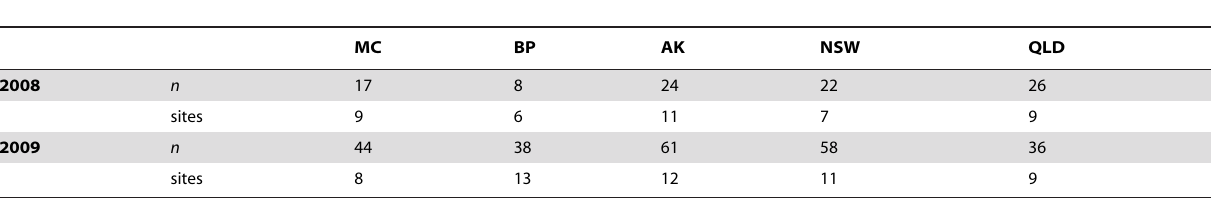
Table 1. Number of H. armigera adult moths reared ( n ) and number of sites